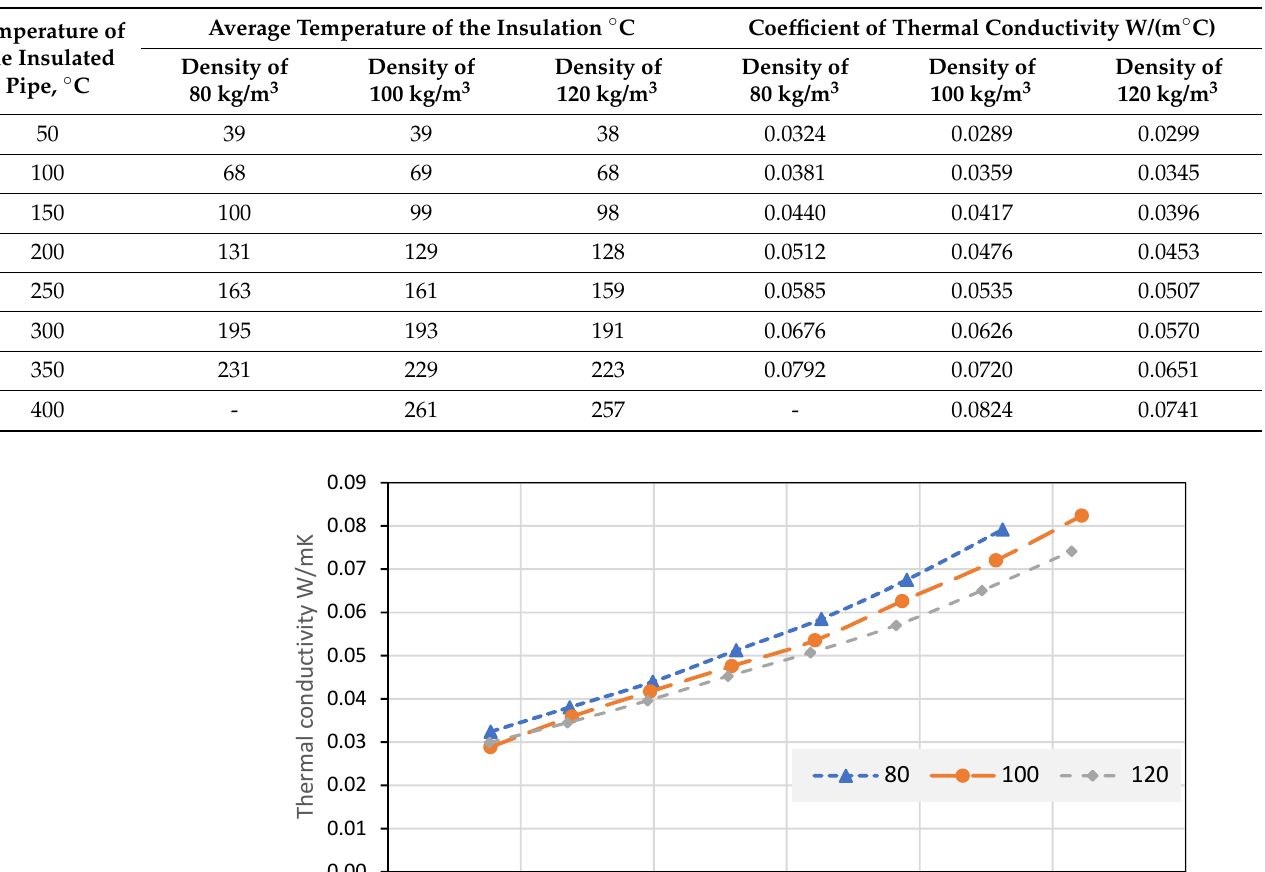
Table 2. Values of the thermal conductivity coefficient for materials with densities of 80, 100, and 120 kg/m 3 for insulated surface temperatures in the range from 50 to 400 ◦ C.